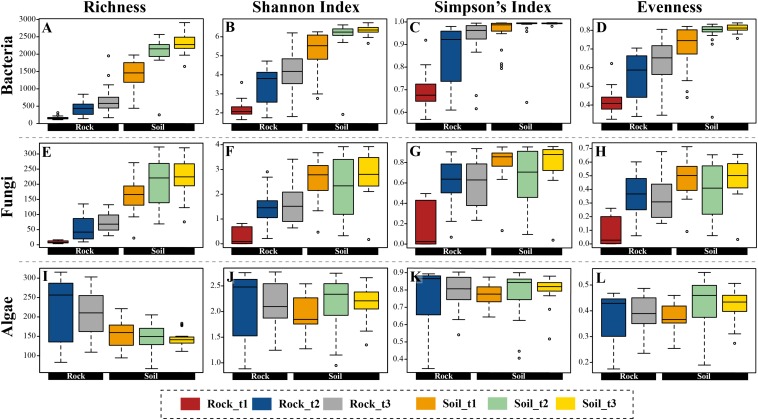
Boxplots representing four alpha-diversity estimators (richness, Shannon and Simpson indices, and evenness) for bacteria (A–D), fungi (E–H), and algae (I–L) calculated with OTU data, and arranged according to substrate type (rocks, soil) and successional stage.